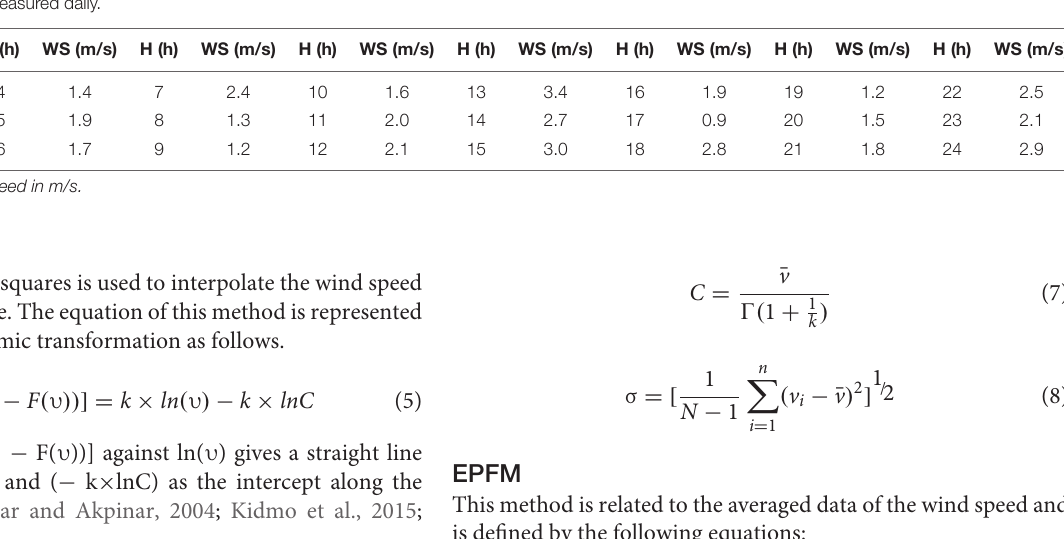
TABLE 1 | Wind speed measured